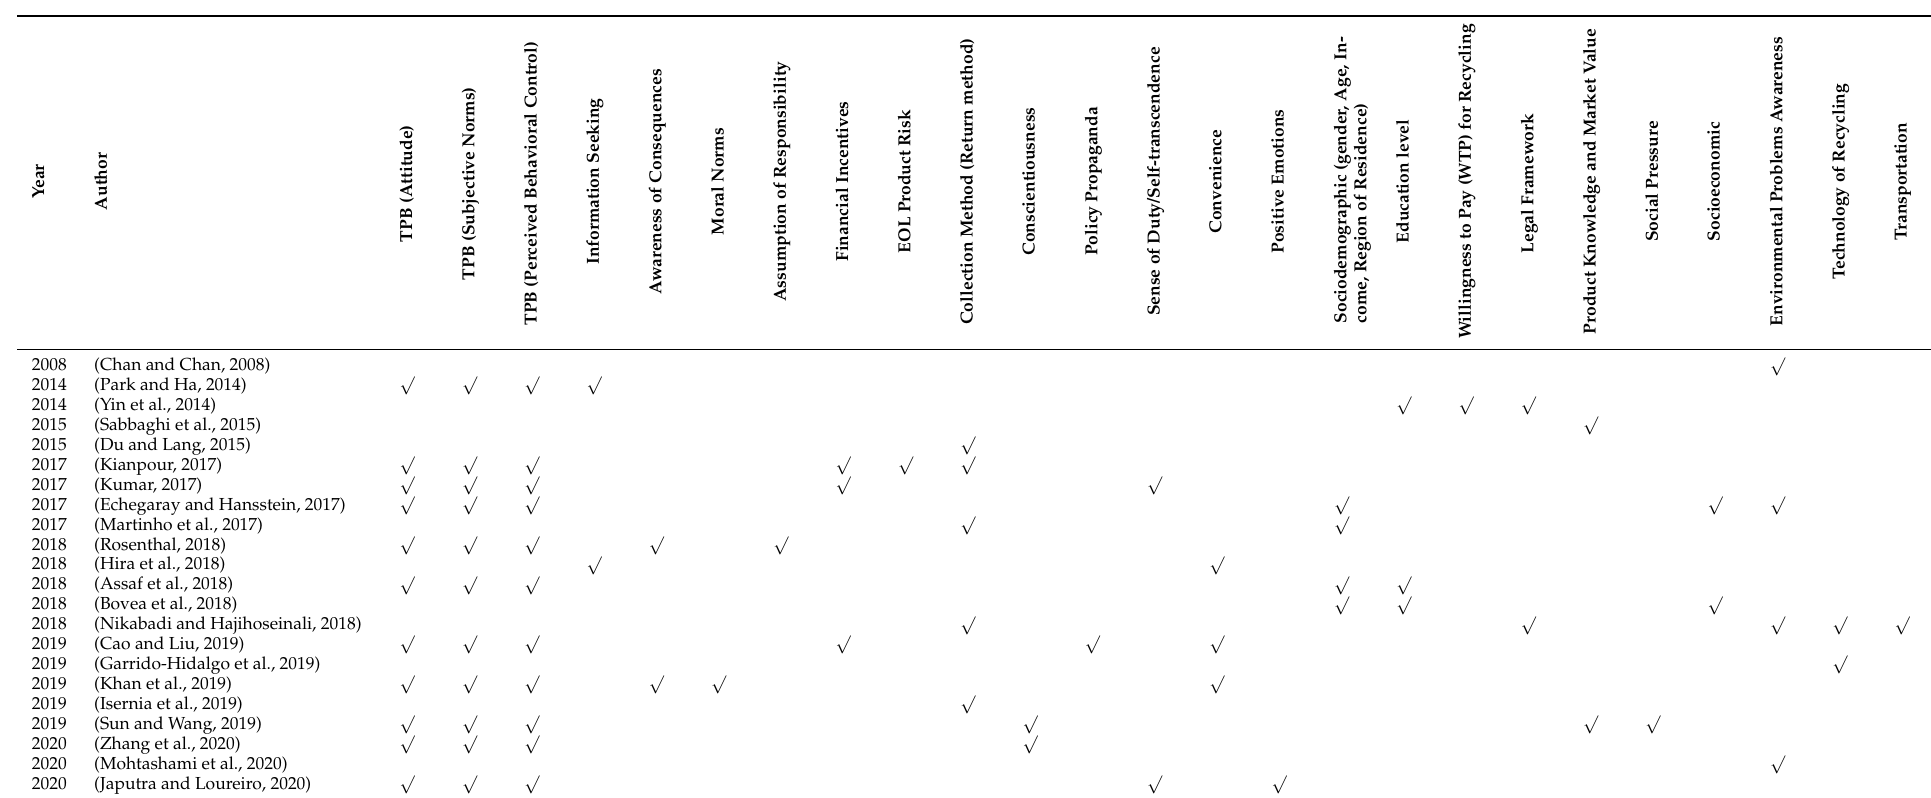
Table 3. Summary of significant contributions made through research on behavioral factors.